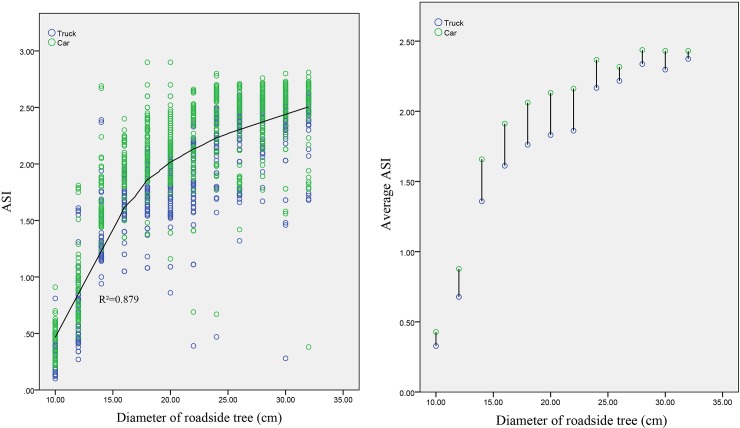
Relationship between the ASI and the tree diameter.